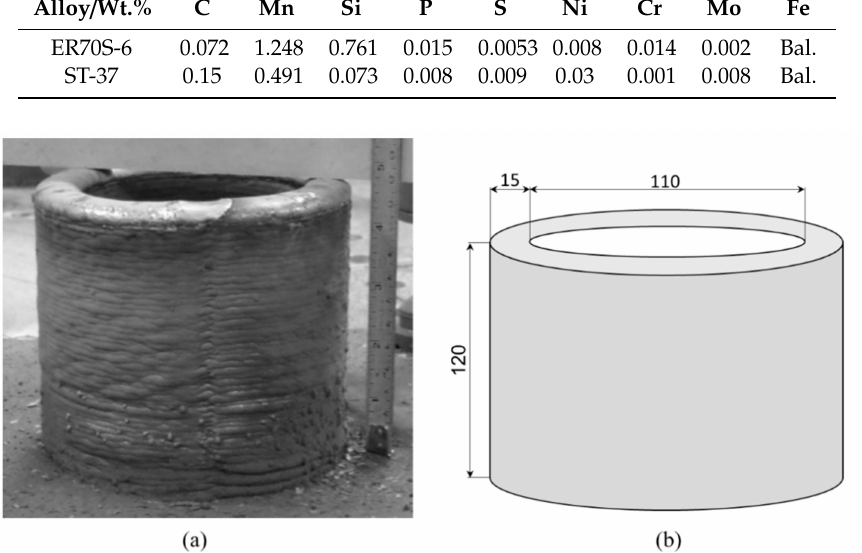
Figure 1. Wire arc additive manufacturing (WAAM) test sample in the form of hollow cylindrical part ( a ) as obtained after printing; ( b ) related geometrical dimension (Unit: